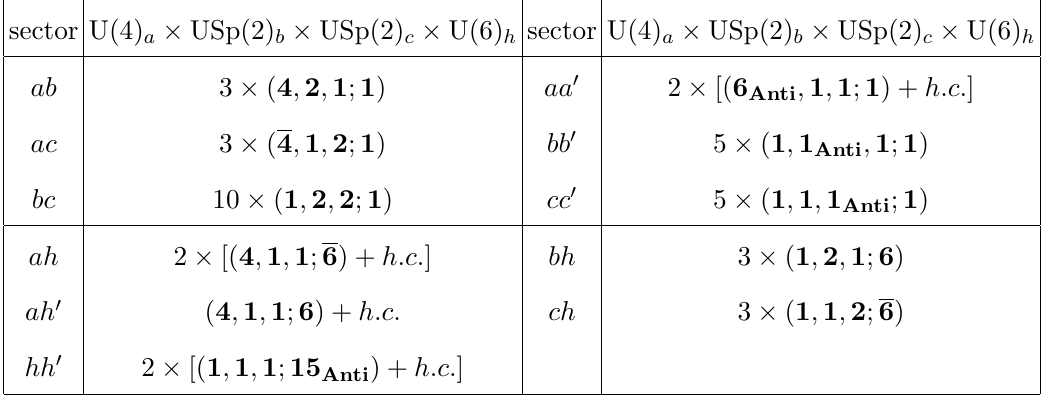
Table 22 . Chiral and vector-like massless (open string) matter spectrum of the prototype I global PS model on the T 6 = ( Z 2 (cid:2) Z 6 (cid:2) (cid:10) R ) orientifold with D6-brane con(cid:12)guration given in table 21. The universal closed string spectrum of all global models in this article can e.g. be found in the caption of table 17. Both U(1) a (cid:2) U(1) d gauge factors acquire masses through the St(cid:127)uckelberg mechanism and survive as perturbative global symmetries at low energies.